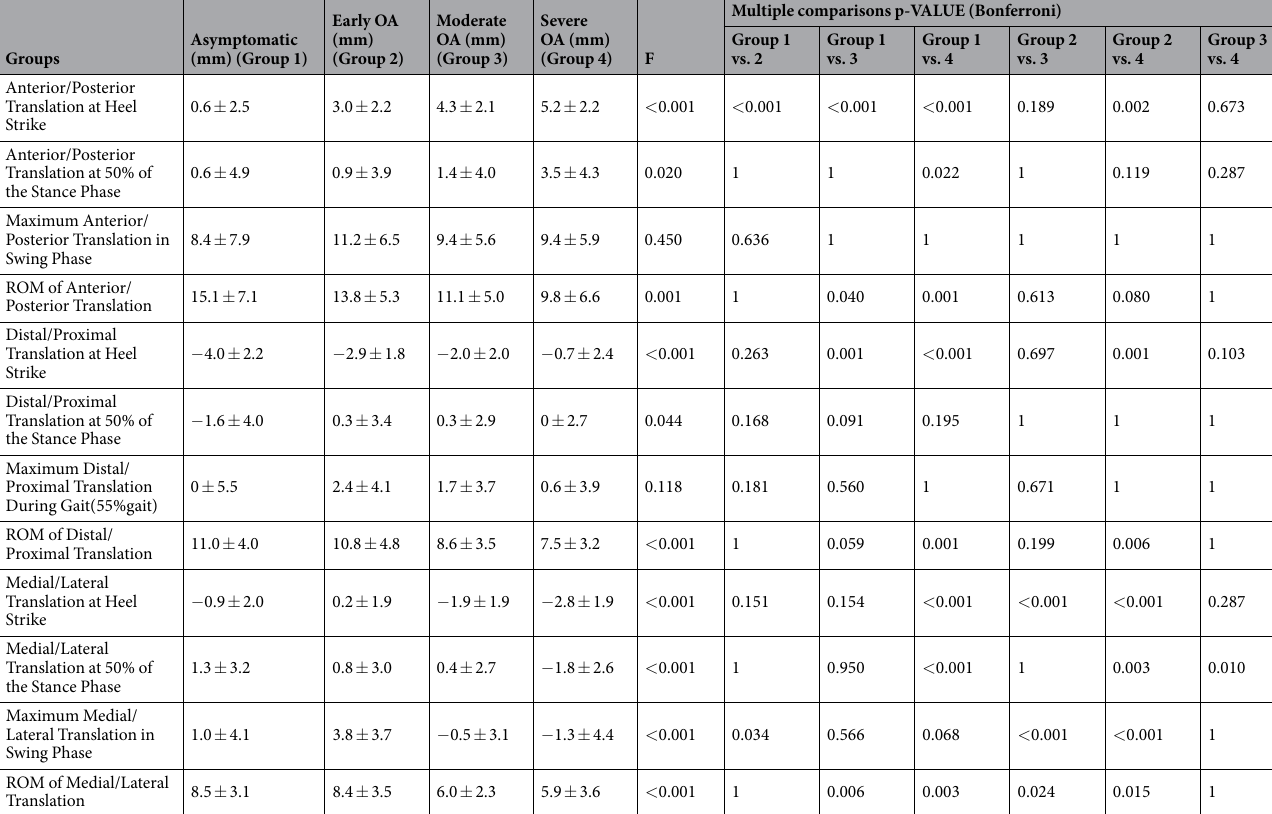
Table 3. Mean ± SD of translation of femur relative to tibia between knee OA severities during gait (in mm). In this table, the key events of the gait at the heel strike and 50% of the stance phase, the maximum translation at the swing phase as well as the range of motion were compared. The multiple statistical differences between different groups were performed by Bonferroni correction.